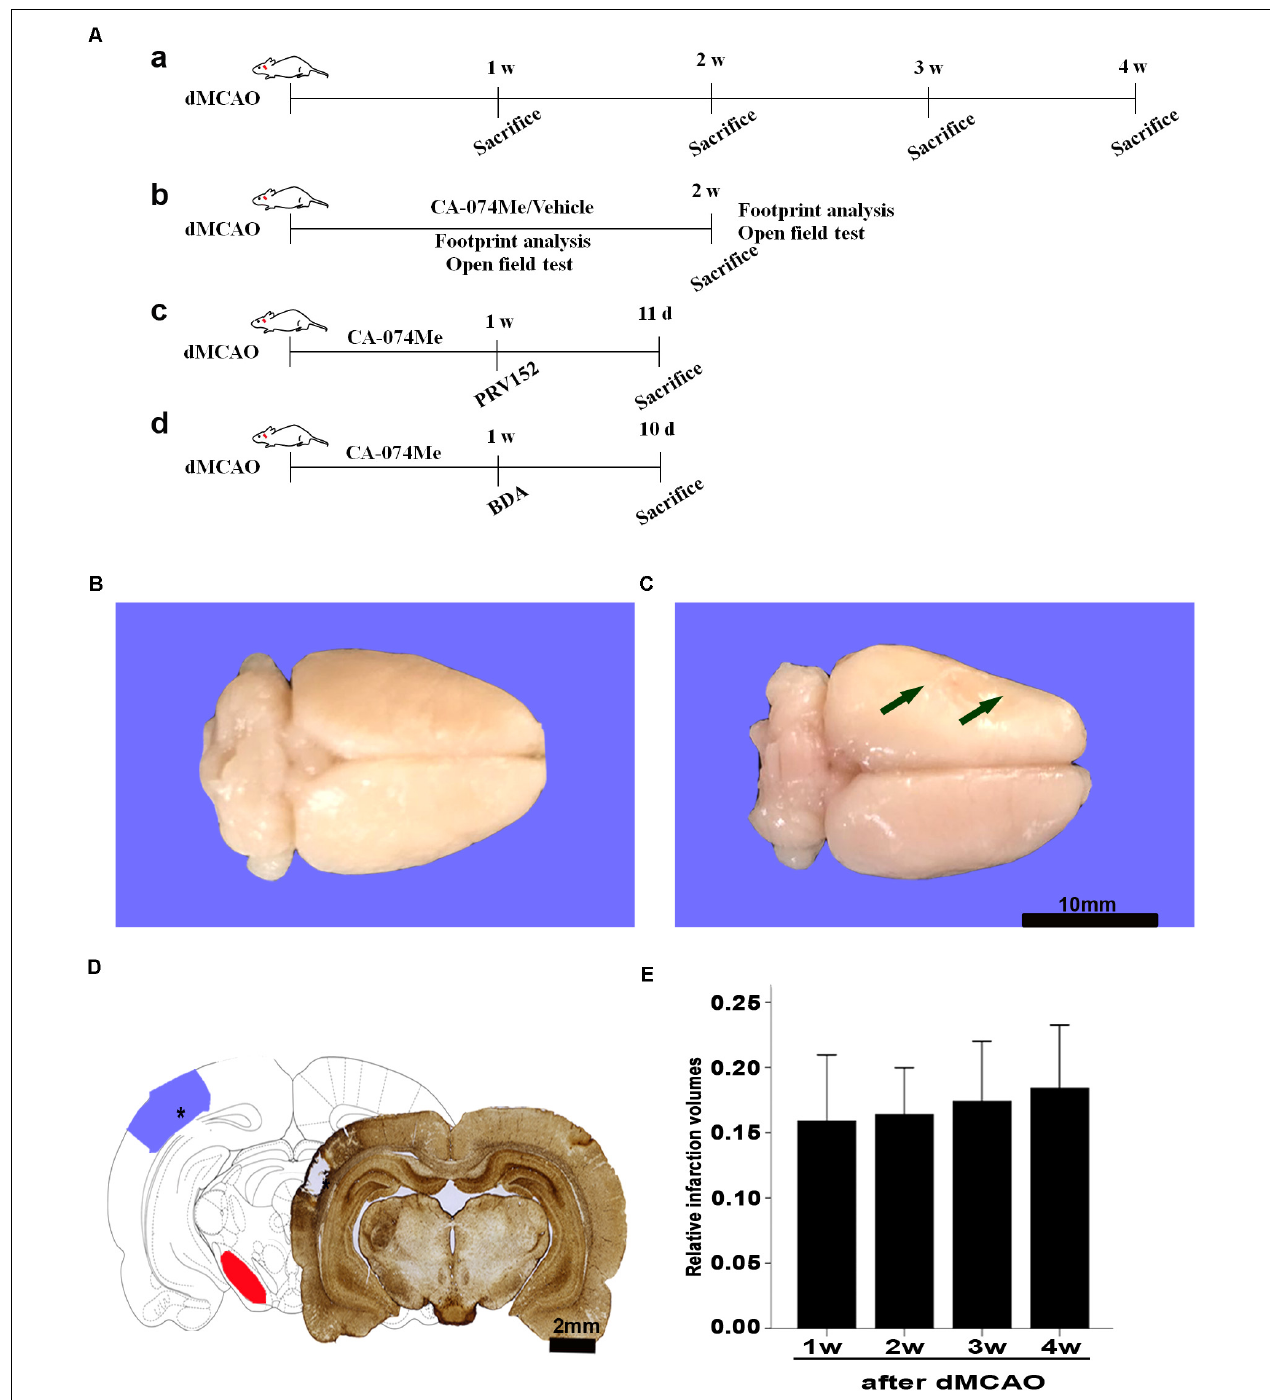
FIGURE 1 | Focal cortical infarction is induced by dMCAO in rats. (A) Study design/timeline of experiments. (a) Rats were sacrificed for immunohistochemistry and Western blotting at 1–4 weeks after dMCAO or sham operation; (b) Footprint analysis and open field test were performed at 1 and 2 weeks, rats were sacrificed at 2 weeks in the vehicle group and CA-074Me group after dMCAO or sham operation; (c) PRV-152 was injected into the ipsilateral SNr at 1 week. Rats were sacrificed at 11 days in sham-operated group, dMCAO group, and CA-074Me group. (d) BDA was injected into the ipsilateral SNr at 1 week, and rats were sacrificed at 10 days in sham-operated group, dMCAO group, and CA-074Me group. (B,C) Gross brain morphology was indicated in the sham-operated and dMCAO groups at 2 weeks after dMCAO. (D) GFAP/DAB-staining confirmed the existence of focal cerebral infarction in the dMCAO group. (E) Relative infarction volumes were evaluated at 1, 2, 3, and 4 weeks after dMCAO ( n = 7, 6, 7, and 6, respectively). The arrow in panel B and the star in panel C indicated cortical infarction after dMCAO. Scale bar in panel B and C is 10 and 2 mm, respectively; w, week; d, day.